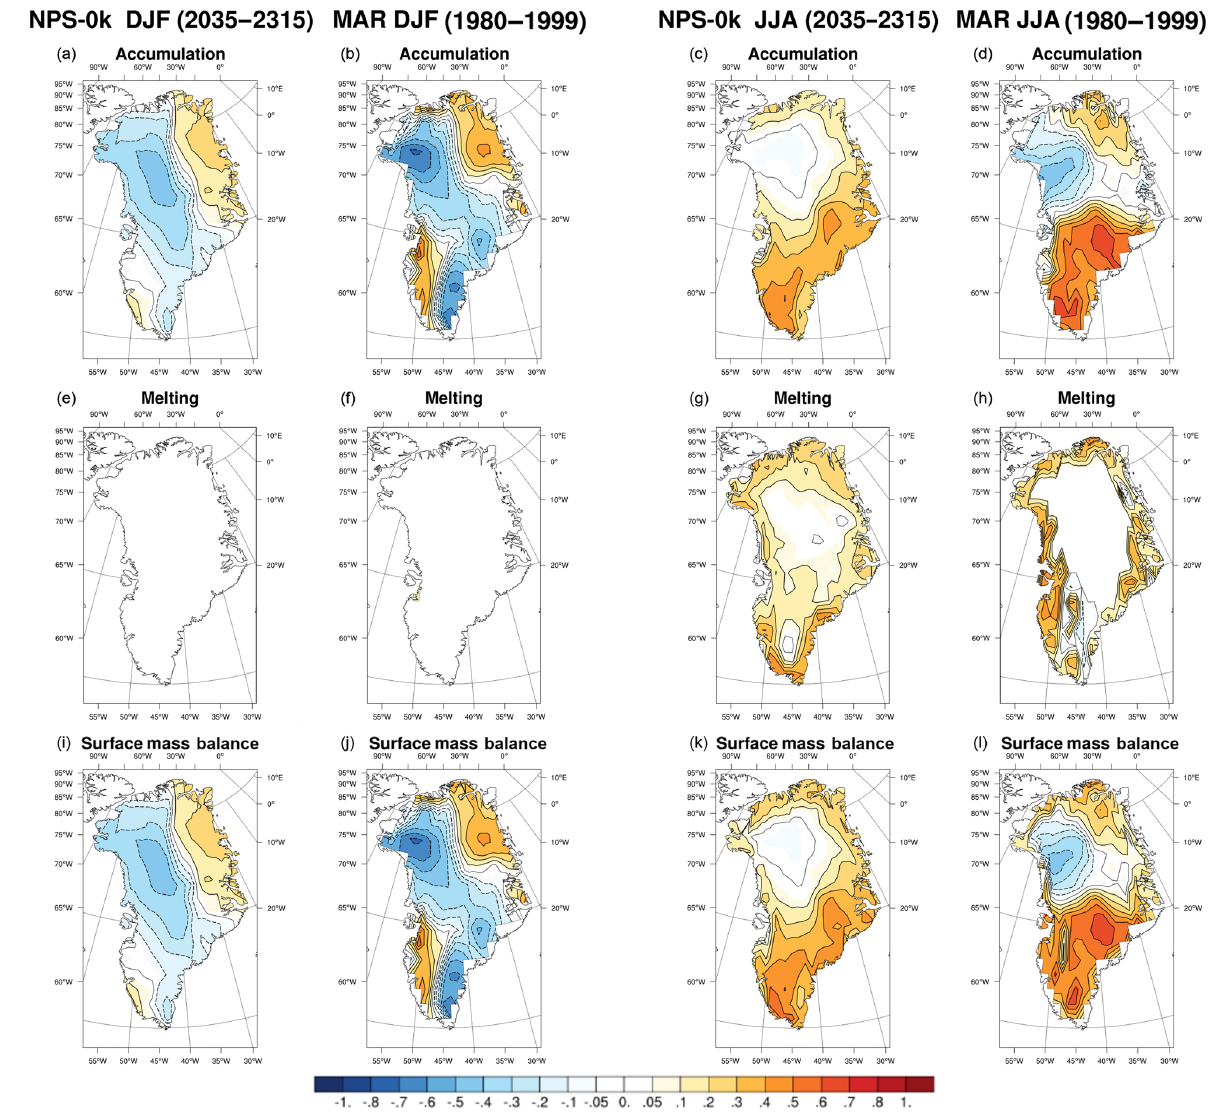
Figure 5. Seasonal (DJF, left two columns, and JJA, right two columns) correlations between the NAO index with mean accumulation (top row), melting (middle row) and SMB (bottom row) over Greenland from NPS-0k (a, c, e, g, i, k) and MAR (b, d, f, h, j, l)